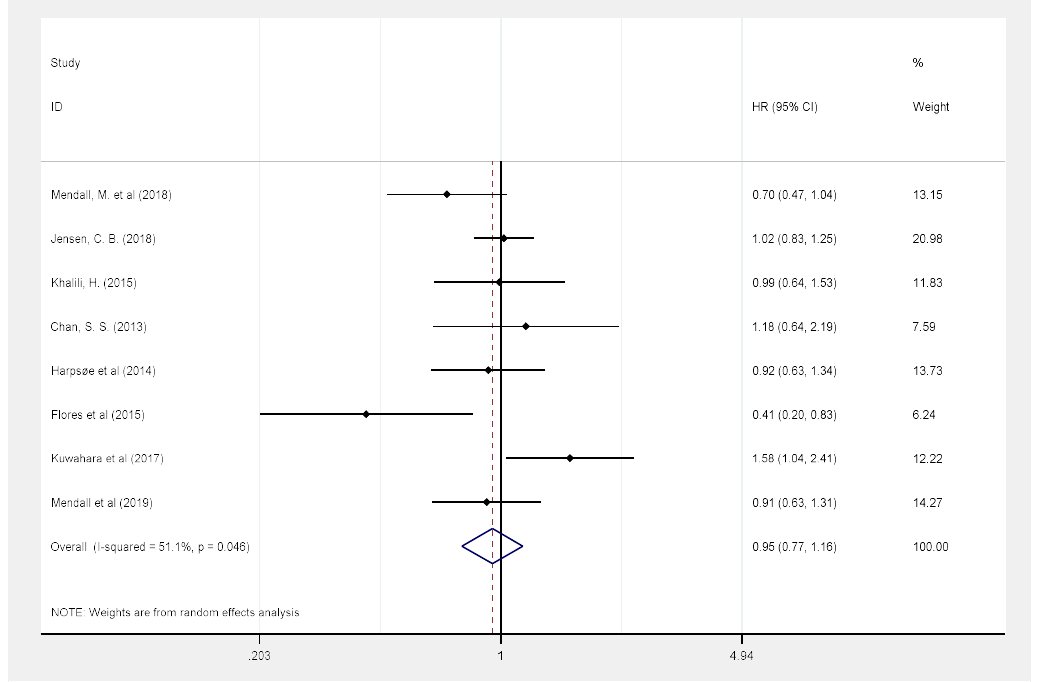
Figure 6. Association between obesity (BMI ≥30 kg/m 2 ) and risk of ulcerative colitis.